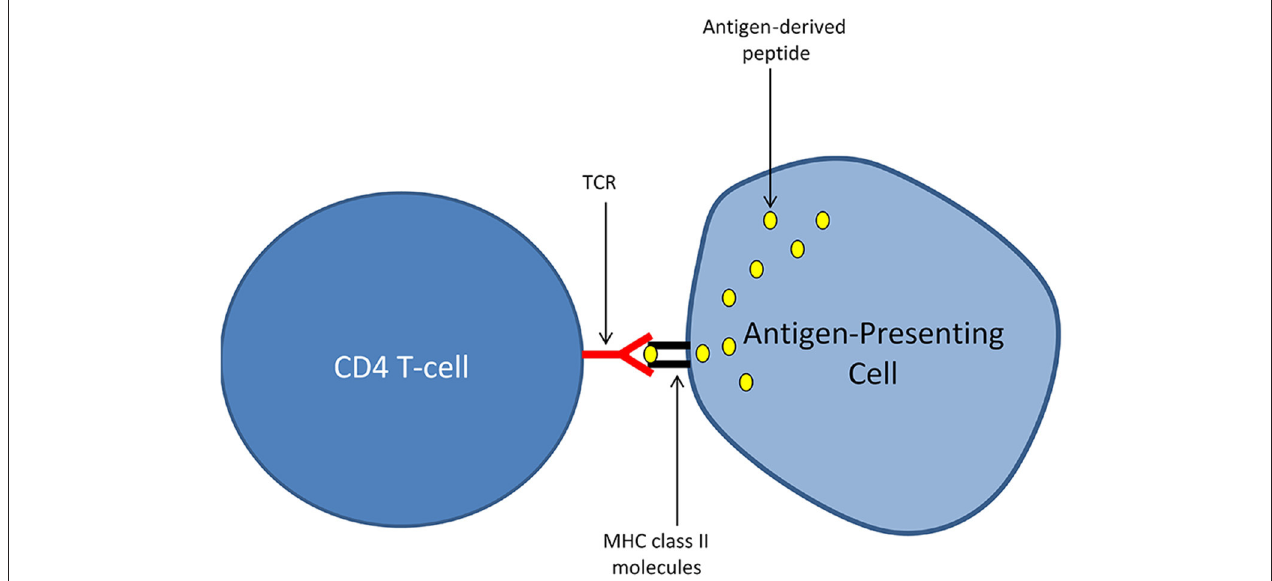
FIGURE 1 | Presentation of antigen-derived peptides to T-cells. The activation of CD4 T-cells in an antigen-specific manner requires a process called antigen presentation and performed by specialized immune cells named antigen-presenting cells (APCs). APCs harbor unique abilities to capture extracellular antigens, to process (i.e., cleave) these antigens into short peptides and to expose at the outer surface of their cellular membrane the peptides generated by antigen processing. There, the exposed peptides are “recognized” by T-cells. Importantly, the recognition of antigen-derived peptides by T-cells also requires that such peptides physically associate with molecules of the major histocompatibility complex class II (MHC class II) that are expressed by APCs. The antigen-specific activation of a CD4 T-cell engages only if the TCR (T-cell receptor) expressed at its cell surface binds with a high affinity the molecular complex formed by: (i) a peptide derived from the targeted antigen and (ii) MHC class II molecules into which the antigen-derived peptide is